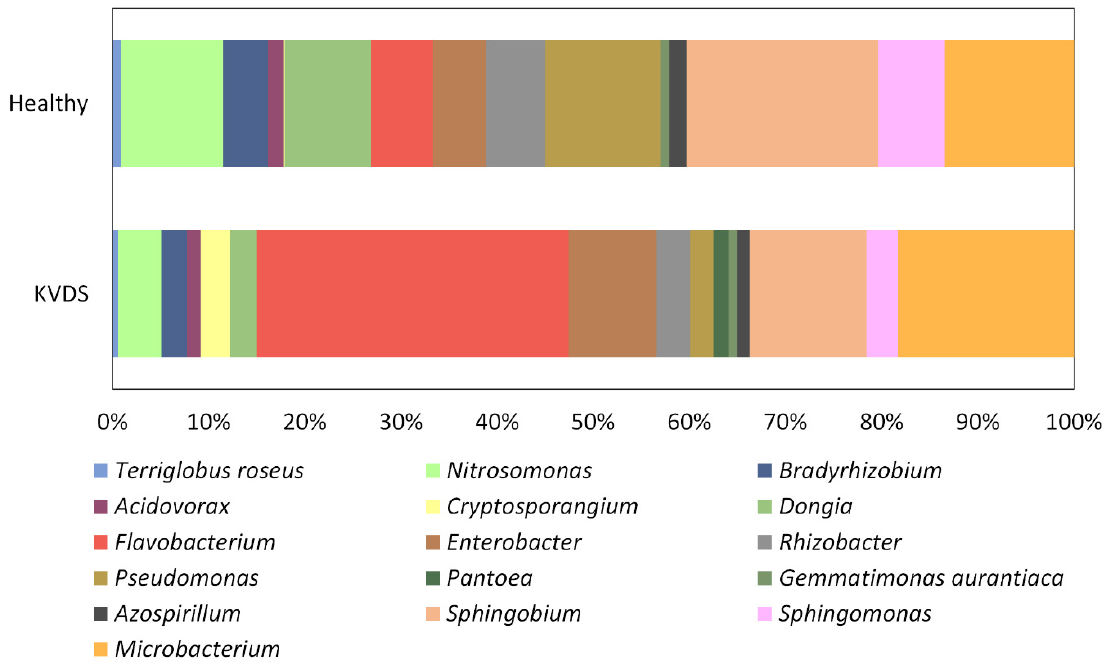
Figure 1. Composition of bacterial community based on relative abundance (%) of different bacterial isolates detected after sequencing the 16S region in the root tissues of affected or healthy vines. Data represent the average of 4 healthy (O3) and 8 kiwifruit vine decline syndrome (KVDS) (O1 + O2) root replicates.